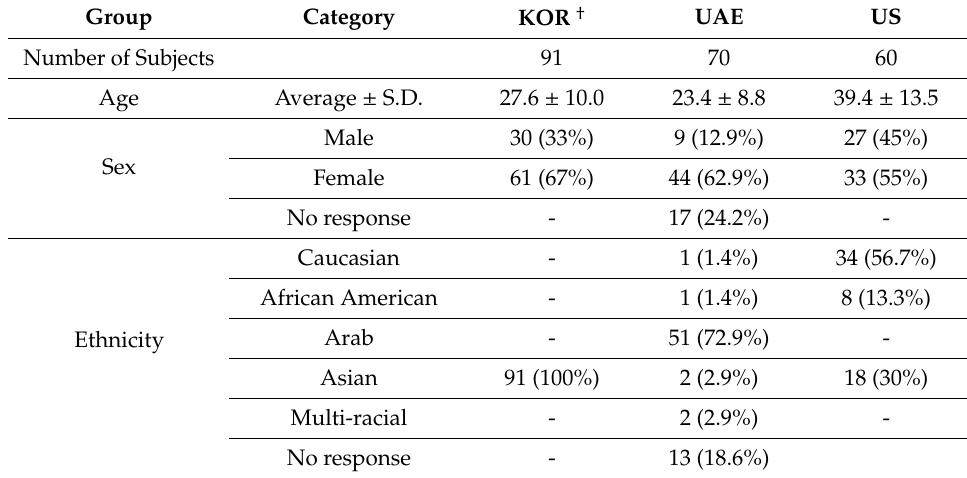
Table 1. Consumers’ demographic information.